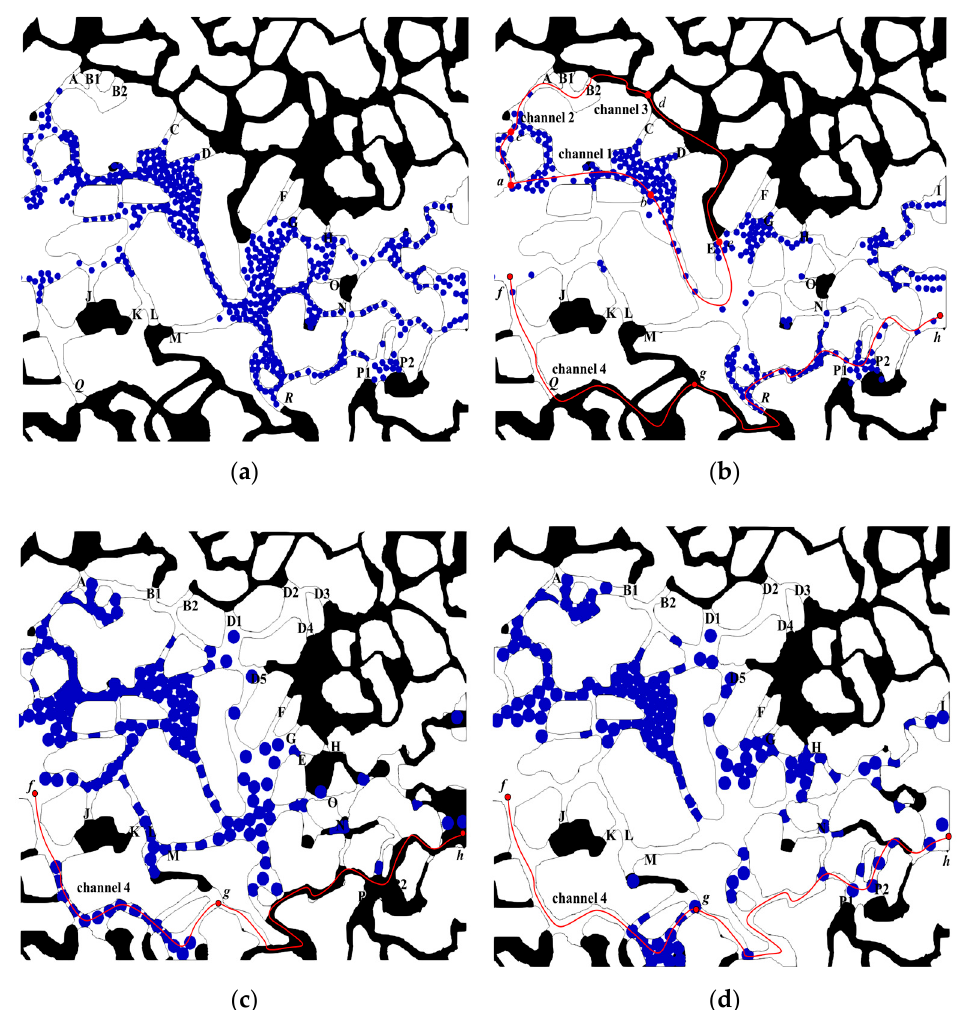
Figure 13. Particle–oil–water distribution at different times for case V (slug injection) and case VI